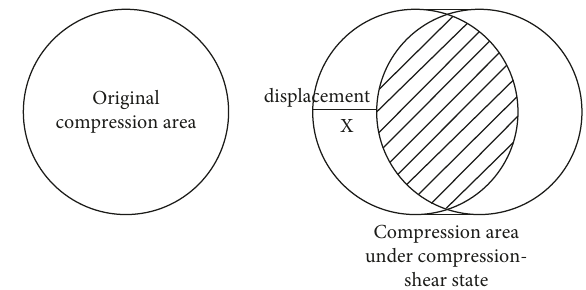
Figure 16: Bearing compression shear state under pressure area reduction.